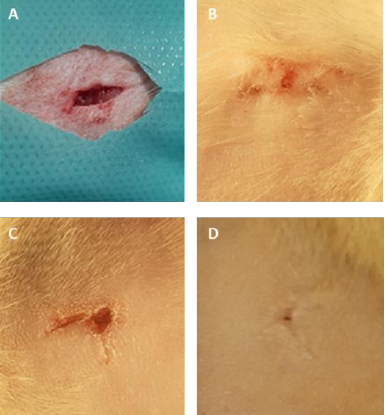
Figure 8. Representative macroscopic images of the skin of rats during and after the implantation procedure. ( A ) The subcutaneous pocket of rat skin created to place films; ( B ) the surface of rat skin 7 days after surgery after the placement of Spongostan; ( C ) placebo film without PVP-I (PVA/HPMC_B/C); ( D ), film with incorporated PVP-I (PVA/HPMC_B/T).